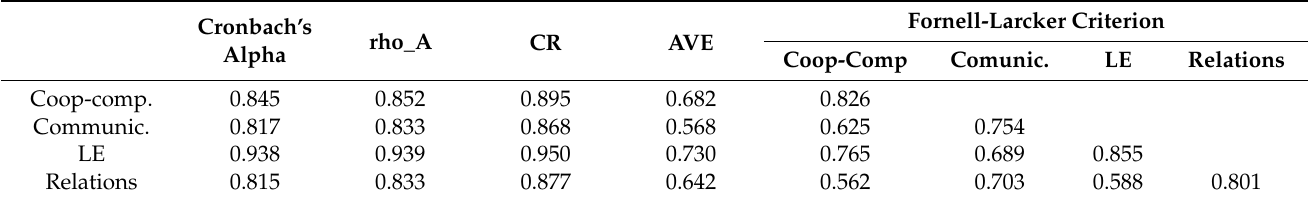
Table 2. Reliability and validity of the constructs and criterion by Fornell–Larcker.